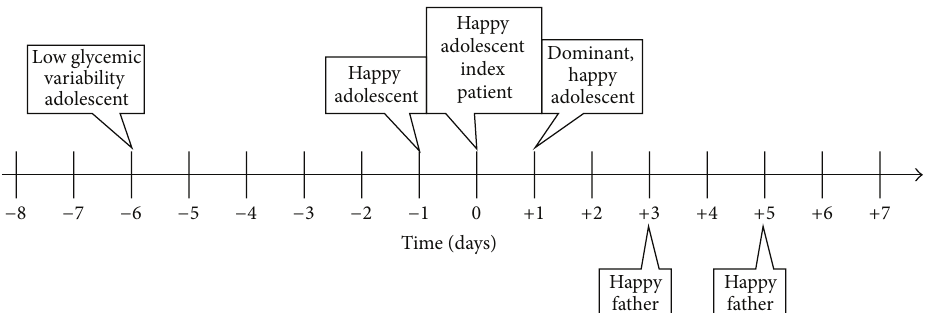
Figure 3: Timeline displaying effects correlating with affective valence in the adolescent index patient. The graph depicts a psychosomatic cycle in which various emotional states of all involved family members influence affective valence (pleasure) of the adolescent patient and vice versa.